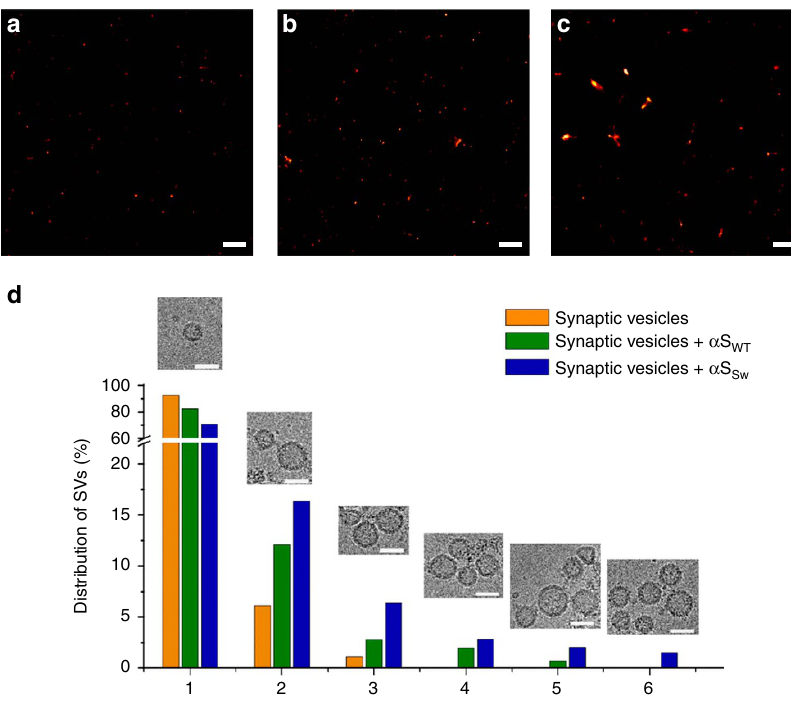
Figure 5 | Clustering of synaptic vesicles promoted by a S. SVs purified from rat brain were incubated for 48h at 37 (cid:2) C. The concentrations during the incubation were 0.5mgml (cid:2) 1 and 85 m M for the SVs and the a S variants, respectively. ( a – c ) dSTORM imaging of SVs alone ( a ) and SVs incubated with a S WT ( b ) and with a S Sw ( c ). The images were collected using a previously described protocol 46 . Scale bars, 1 m m. To generate fluorescent SVs, we used a primary antibody that is specific for synaptotagmin 1 and a secondary antibody that is covalently linked to an ATTO 647 N dye. 10,000 fluorescence frames with an exposure time of 10ms were recorded. The field of view imaged covered 1,997 (cid:3) 1,997 camera pixels, corresponding to an area on the sample of B 20 (cid:3) 20 m m 2 . ( d ) To assess the level of clustering of the SVs, we adapted an approach that has previously been successfully employed to analyse protein self-assembly. 47 For each dSTORM image, clusters of SVs were identified on the basis of the distances between the centres of mass of the SVs. In particular two or more vesicles were associated with a specific cluster if their distances apart are less than 60nm. The distribution of SVs in clusters of different sizes is reported using orange, green and blue histograms for SVs, SVs in the presence of a S WT and SVs in the presence of a S Sw , respectively. Cryo-EM images (scale bar, 50nm) show representative clusters of different